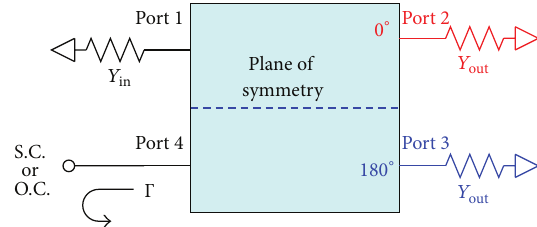
Figure 1: Balun topology as a symmetric four-port network.